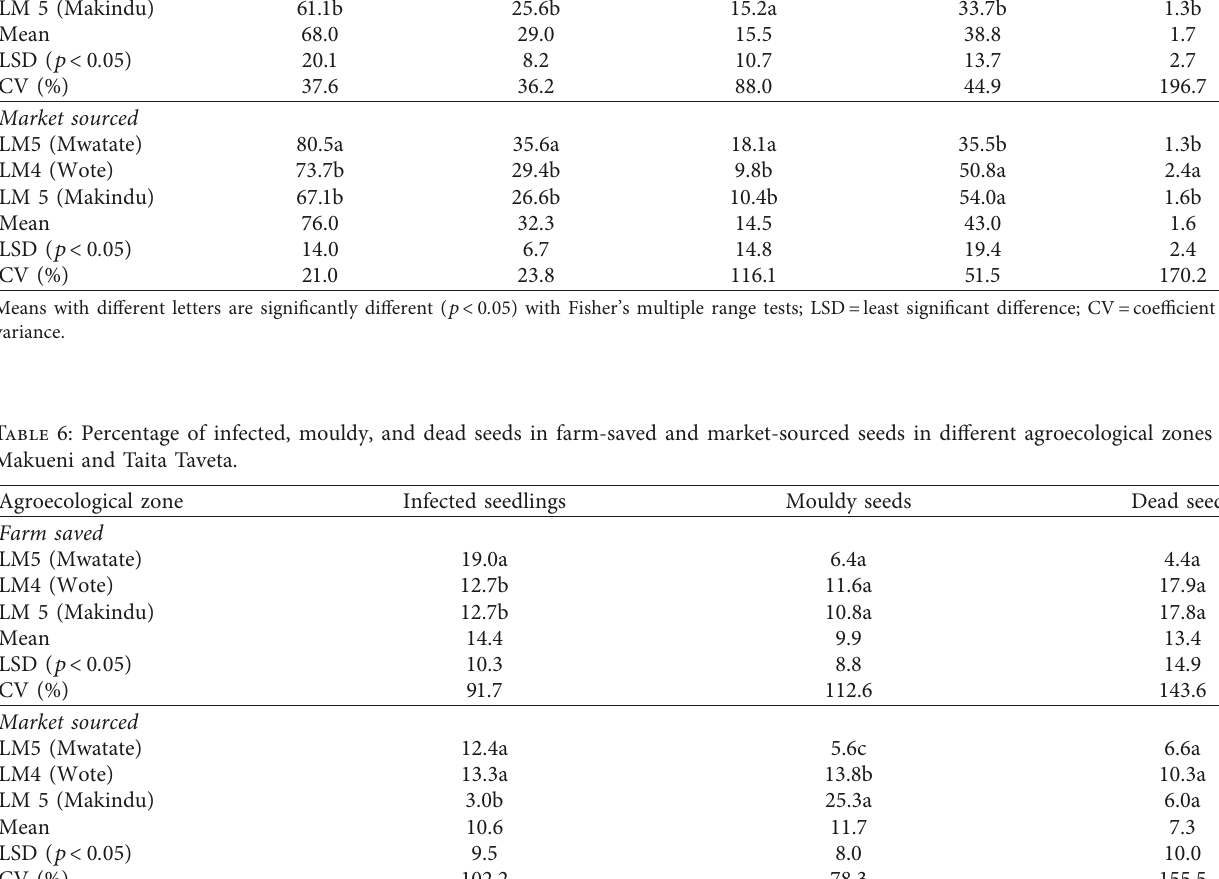
Table 5: Percentage viability of farm-saved and market-sourced seeds from different agro ecological zones in Makueni and Taita Taveta. Agroecological zone Germination (%)